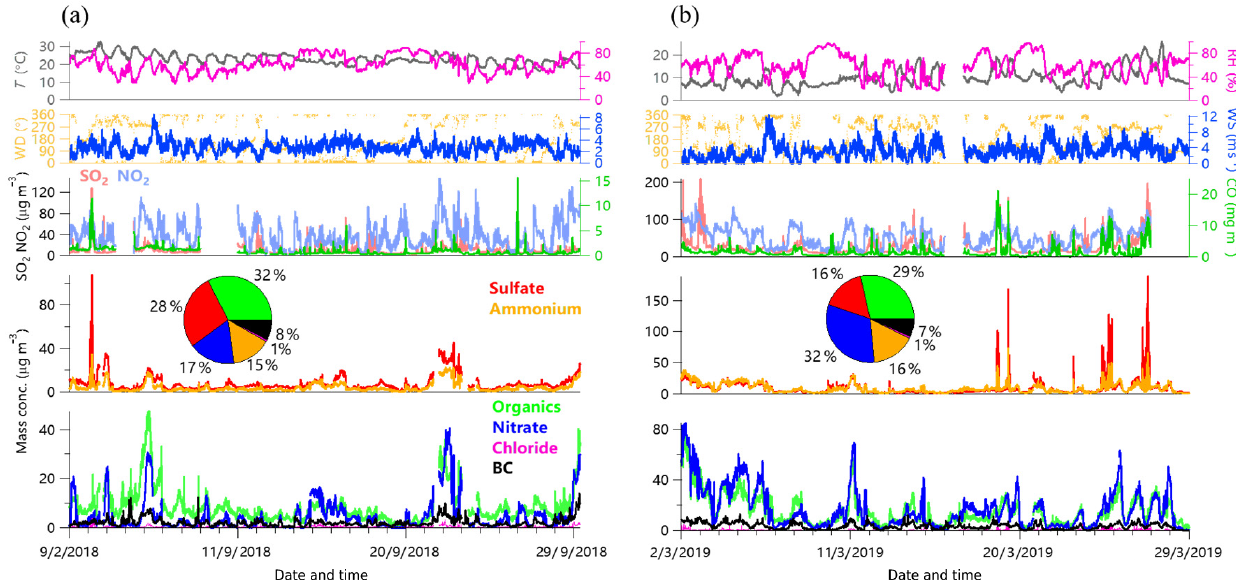
Figure 2. Time series of meteorological variables including T , RH, WD, and WS; mass concentrations of gaseous species including SO 2 , NO 2 , and CO; and chemical species in PM 2 . 5 in (a) September 2018 and (b) March 2019, respectively. The pie charts show the average chemical composition for the entire campaign.